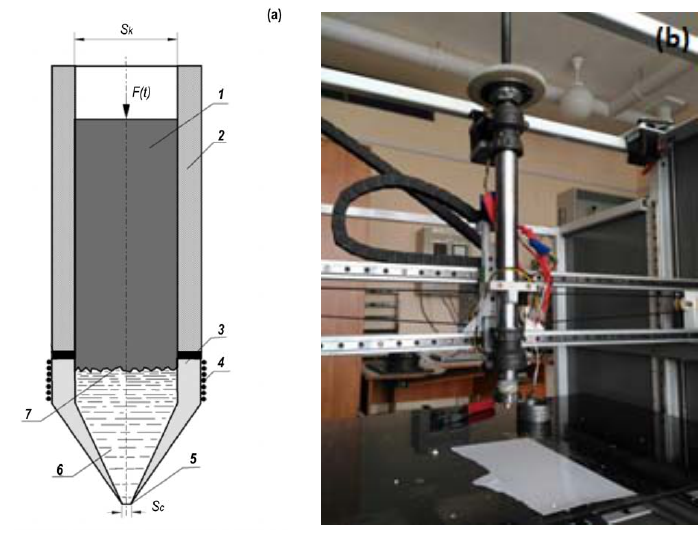
Figure 3. Extruder ( a ) scheme and ( b ) general view.